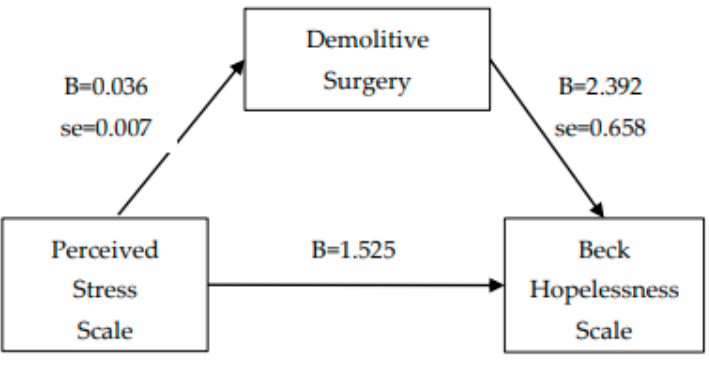
Figure 1. Mediation analysis_1 (Sobel test = 2.969, SE = 0.029, p = 0.002). From simple linear regression, demolitive surgery was a statistically significant pre- dictor of perceived stress. Furthermore, demolitive surgery was also a significant predictor of the mediating variable (previous breast surgery). When the mediator, previous breast surgery, was entered in the regression analysis, demolitive surgery was no longer a signifi- cant predictor of perceived stress. Finally, the Sobel test confirmed previous breast surgery as a potential mediator of the association between demolitive surgery and perceived stress (see Figure